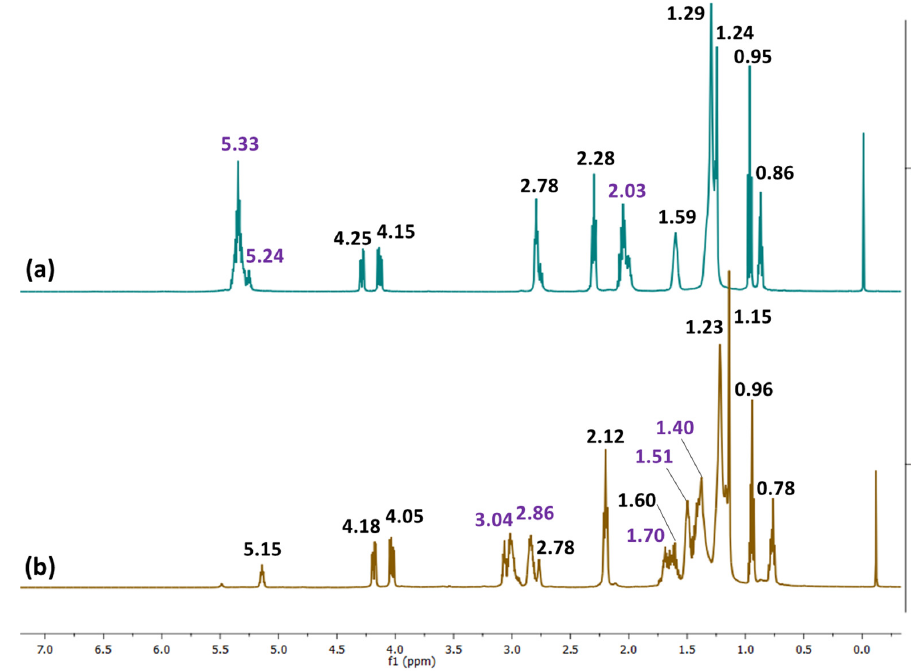
Polymers 2023 , 15 , 439 Figure 2. 1 H-NMR spectra of ( a ) crude LALO and ( b ) epoxidized LALO. Figure 2. 1 H-NMR spectra of ( a ) crude LALO and ( b ) epoxidized LALO.